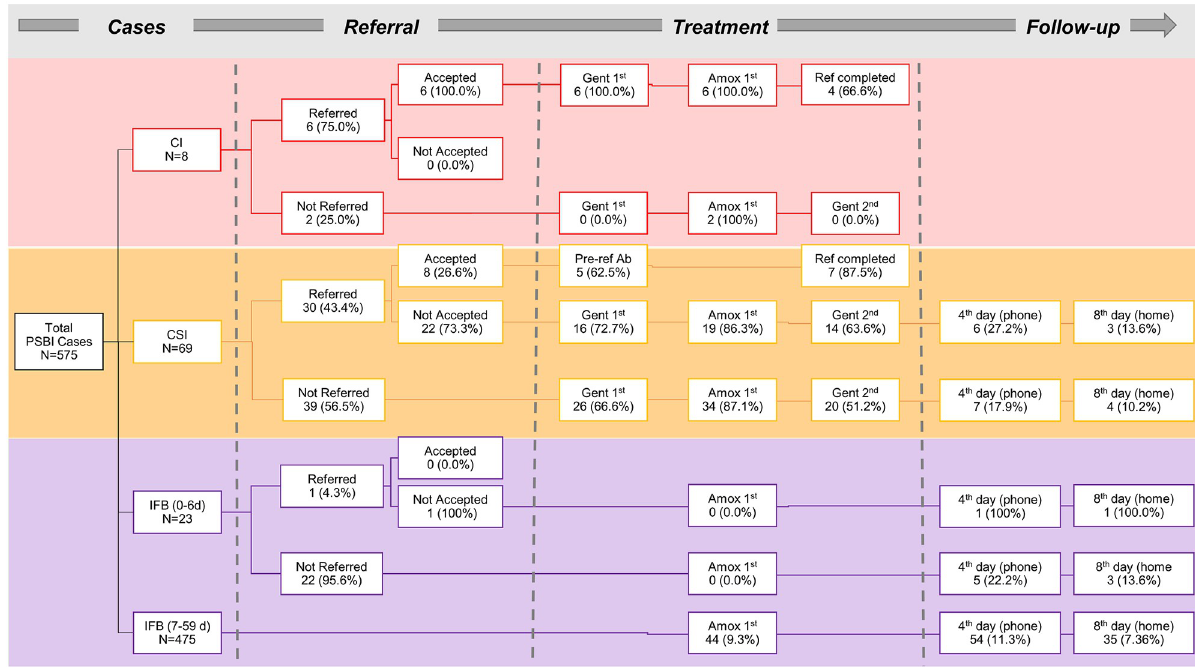
Fig 4. Providers’ adherence to guidelines for management of sick young infants with PSBI in UH&FWC facilities, (data source: Caregiver report from community case tracking, N = 575).